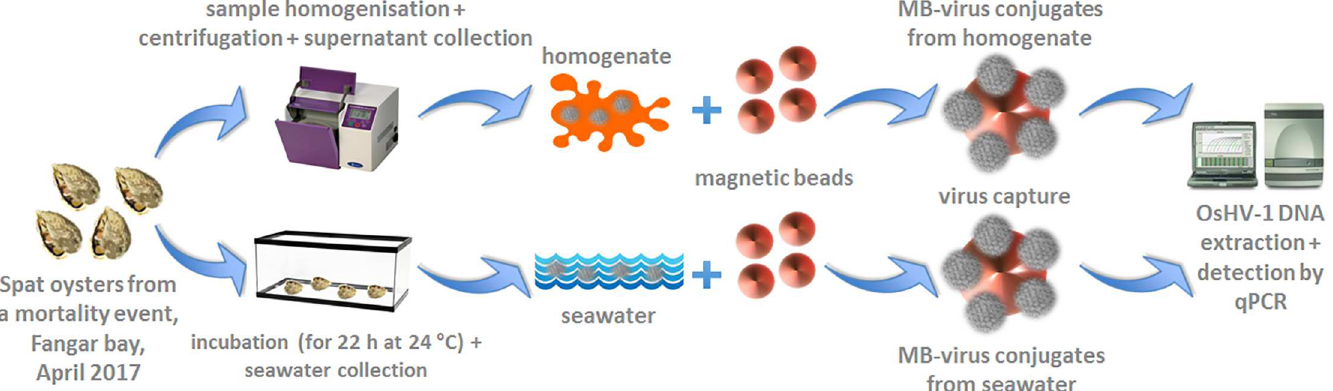
Fig 1. Schematic representation of the protocol for the capture of viable OsHV-1 from the homogenate and the seawater using anionic MBs and subsequent virus detection.